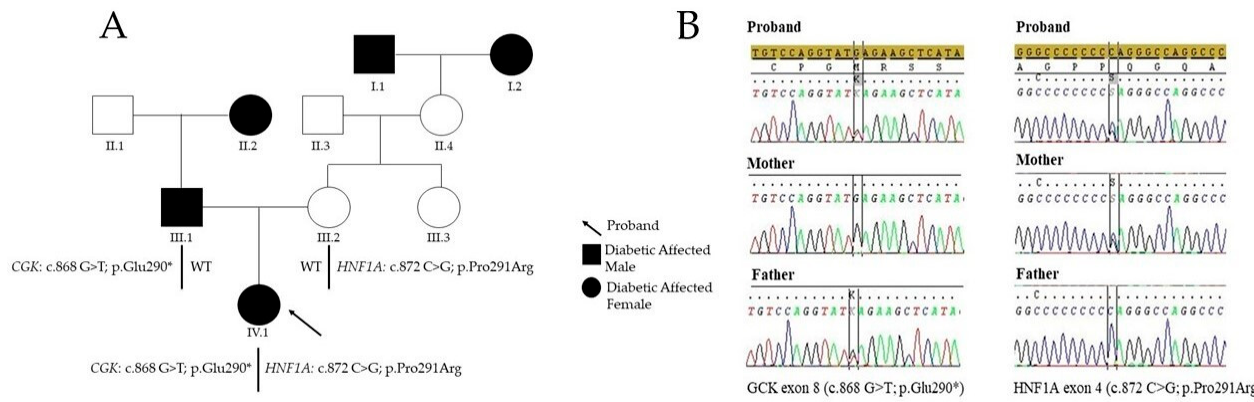
Figure 1. ( A ) Pedigree of the analyzed family. The pedigree shows the segregation of the variants detected in the proband and her family. In the subject III.1, the variant, carried in the heterozygous status, is the c.868 G > T; p.Glu290*, in the glucokinase (CGK) gene; the III.2 subject carried the c.872 C > G; p.Pro291Arg, in the HNF1A gene. The proband of the study (IV.1) shows all the two variants cited above in the parents. I.1 and I.2 proband’s maternal great-grandparents: diabetes; II.2 proband’s paternal grandmother: diabetes; III.1 proband’s father: diabetes, obesity; III.2 proband’s mother: obesity, thrombophilia; III.3 proband’s aunt: thrombophilia; IV.1: diabetes ( B ) GCK and HNF1A Sanger sequences of the proband, the mother, and the father.